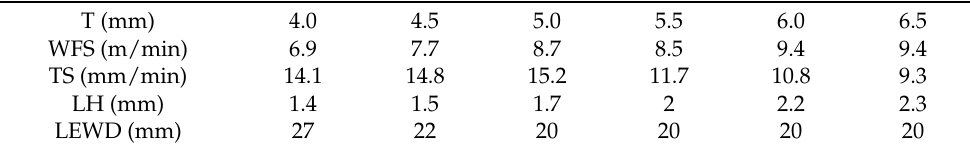
Table 5. WAAM parameters estimated through numerical optimization for different target wall width (T) values.